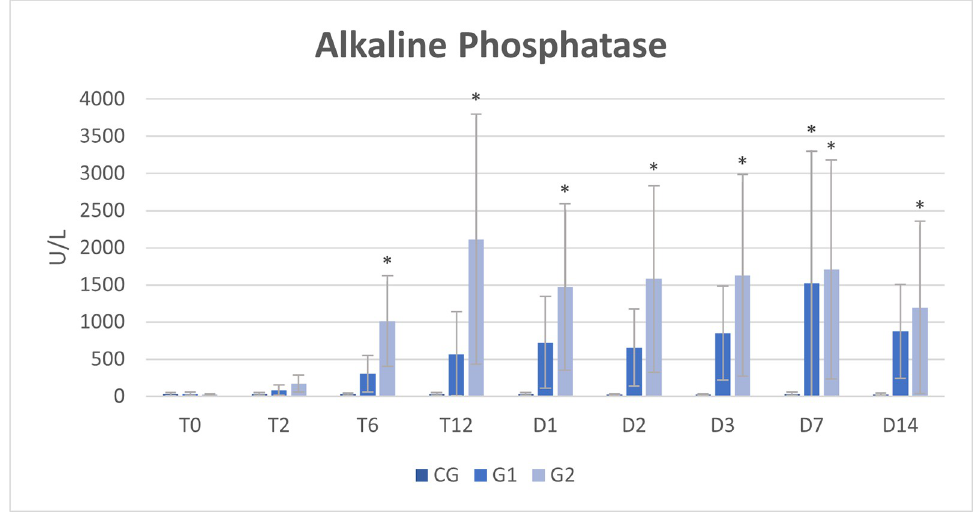
Table 8. Mean and standard deviation (SD) of serum ceruloplasmin of healthy horses (CG) and horses submitted to cecal trocarization with a cecal needle (G1) or a cattle trocar (G2). Ceruloplasmin (mg/dL) Time CG